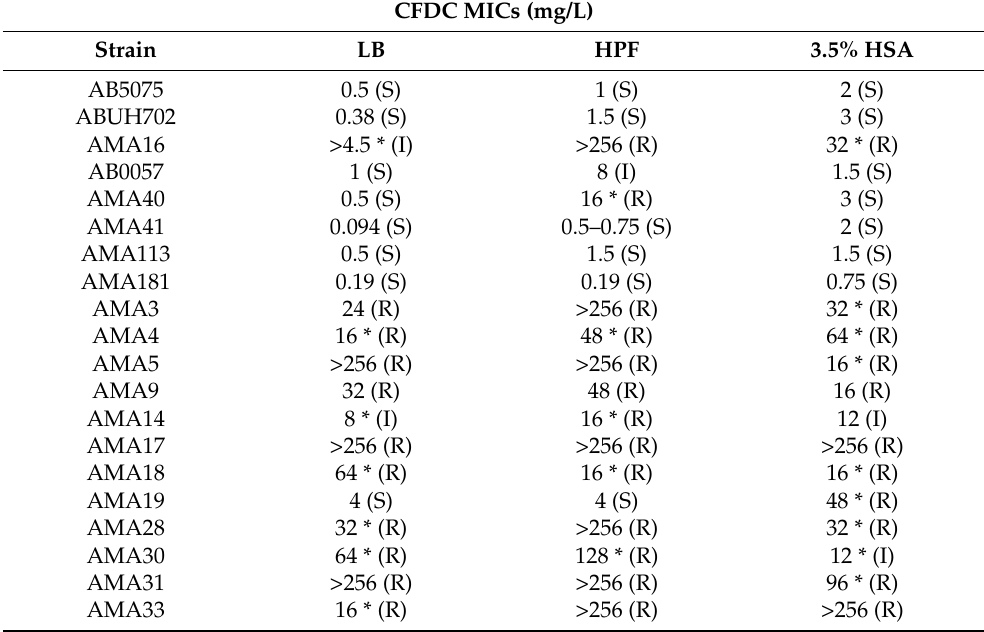
Table 1. Minimal inhibitory concentrations of cefiderocol (CFDC) for 22 carbapenem-resistant Acinetobacter baumannii representative strains performed using CFDC MTS strips (Liofilchem S.r.l., 64026 Roseto degli Abruzzi TE, Italy) on Mueller–Hinton agar (cation adjusted). A. baumannii cells were cultured in LB or LB supplemented with 3.5% HSA or HPF,